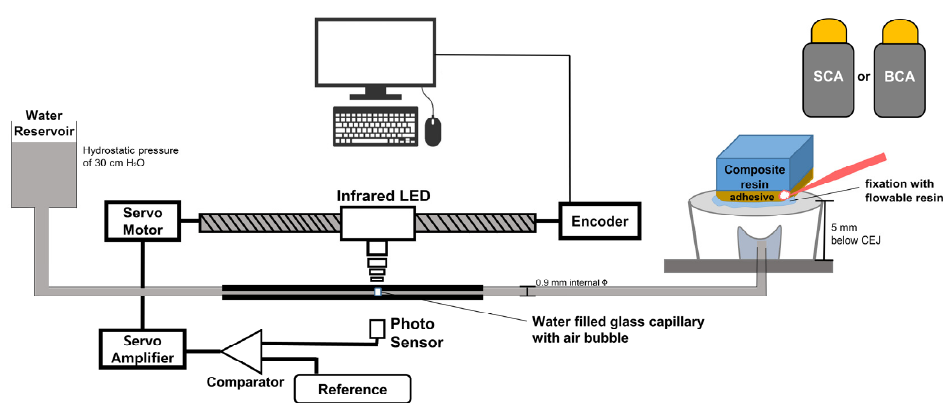
Figure 1. Schematic diagram of the real-time dentinal fluid flow (DFF) rate measurement device . The prepared specimen was connected to a glass capillary filled with water containing an air